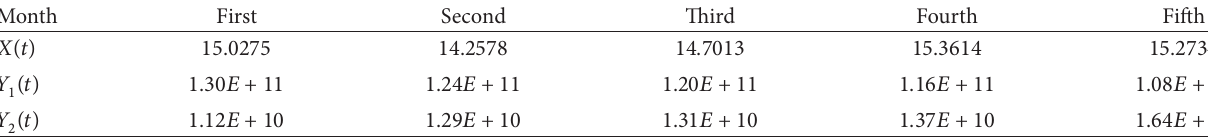
Table 4: The input and outputs center of gravity for DMU 3 .